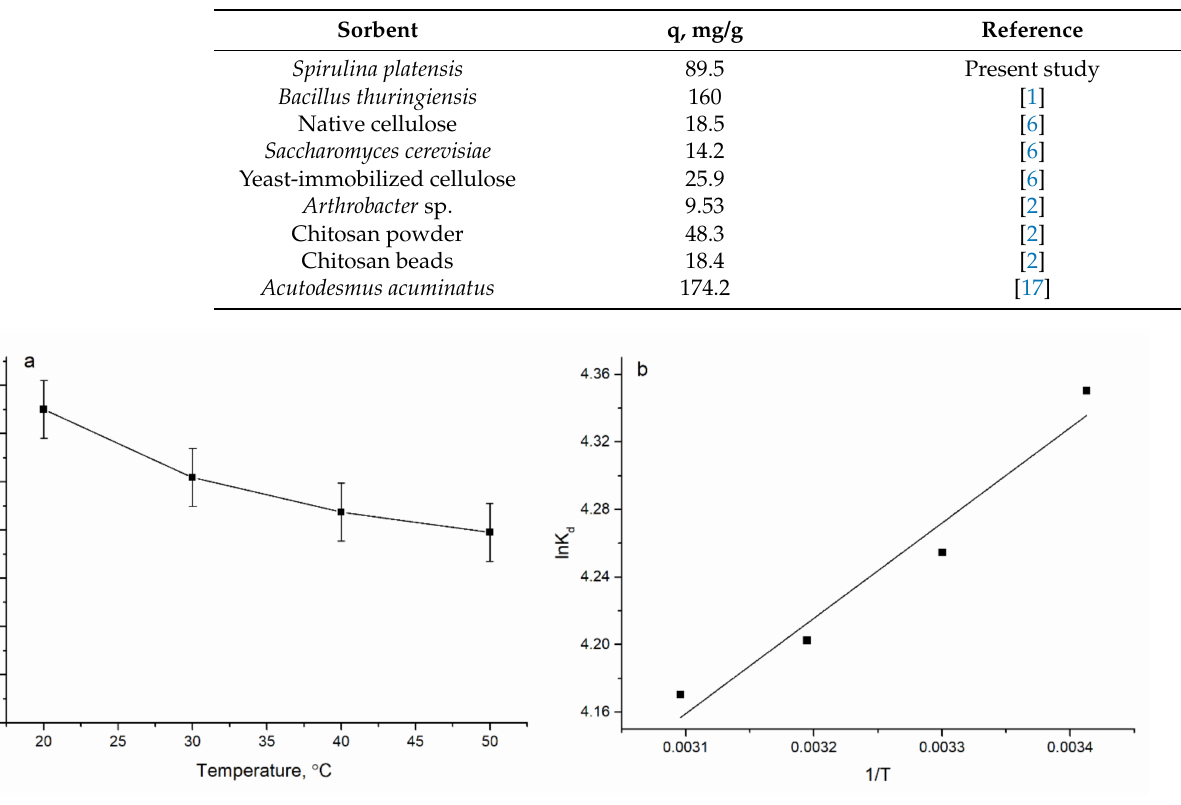
Figure 3. ( a ) Effect of temperature on Eu(III) removal and ( b ) lnK d versus 1/T. The free energy, enthalpy, and entropy changes were obtained from the plot of lnK d against 1/T (Figure 3b) and are presented in Table 3.